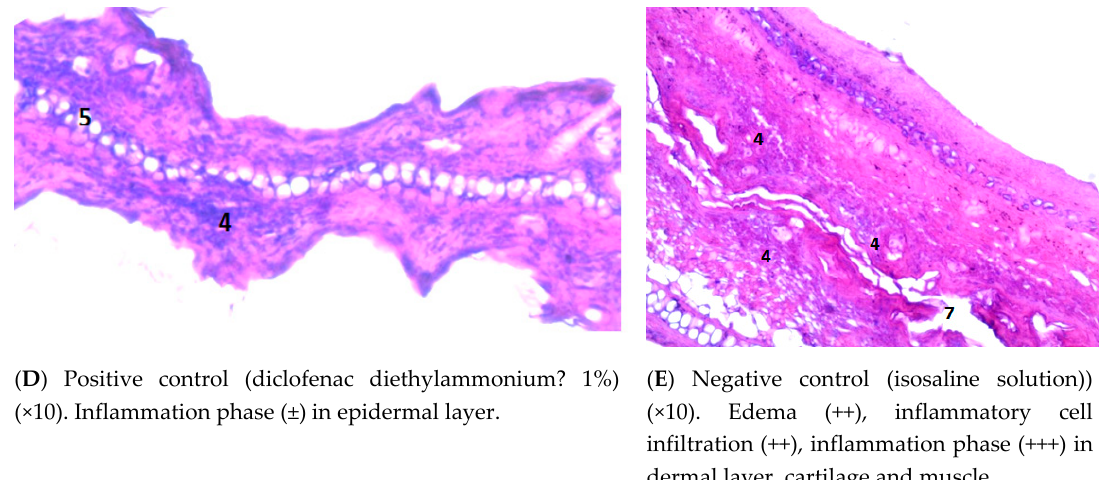
Figure 5. Histological fragments of mice ear biopsies displaying epidermal, dermal and bone layers. H&E stained sections were recorded as minor ( + ), moderate ( ++ ) and great ( +++ ) for edema and inflammatory (polymorphonuclear) cell infiltration. (1) keratin; (2) epidermal layer; (3) epithelium; (4) polymorphonuclear cells infiltration (PMN); (5) cartilage layer; (6) muscle; (7) edema.